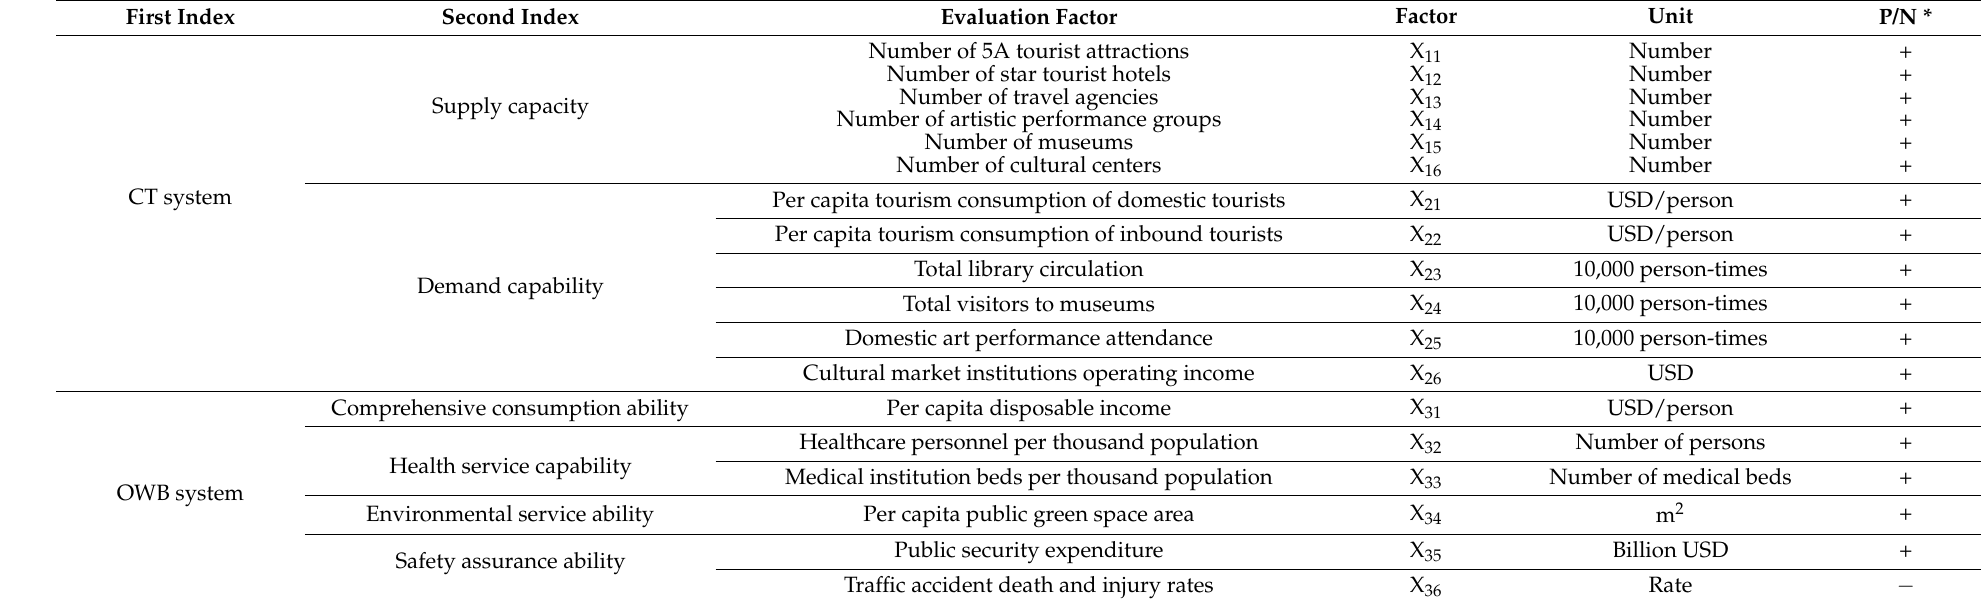
Table 1. Main evaluation index system of cultural tourism and residents’ objective